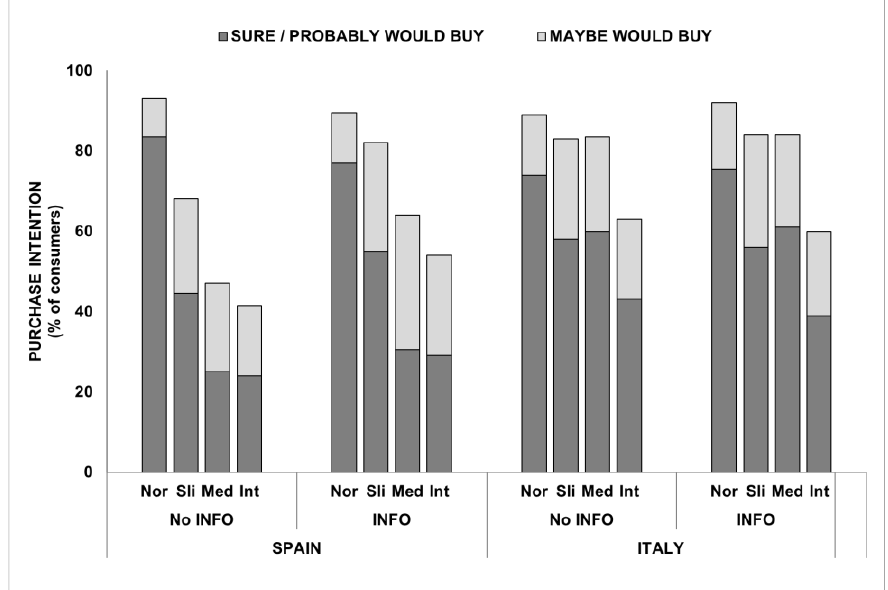
Figure 4. Purchase intention of Spaniards (SP) and Italians (IT) for mandarins with different pulp pigmentation intensities (normal, slight, medium and intense). The Informed consumers (Info) received information about the antioxidant properties of the pigmented mandarins.